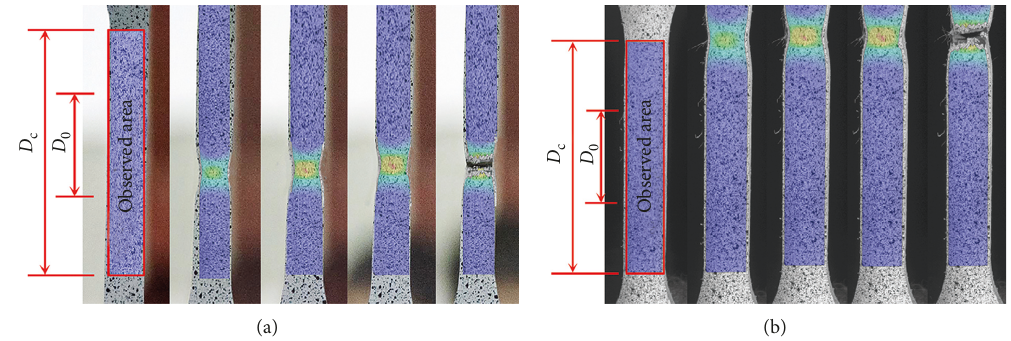
Figure 6: Strain nephograms of flat and corner coupons: (a) strain of flat coupon; (b) strain of corner